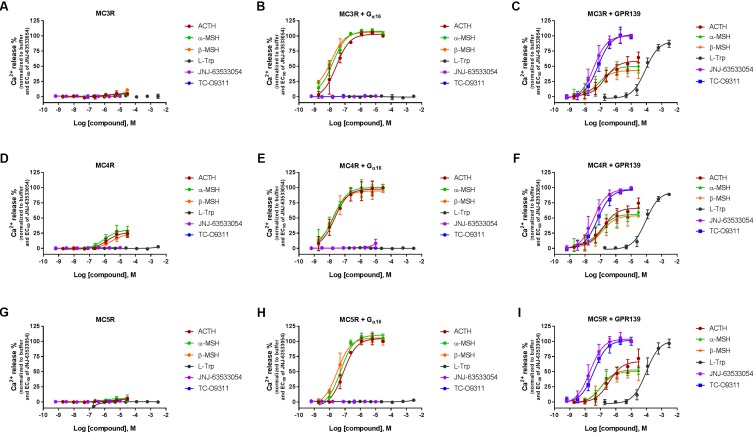
Concentration response of the MC agonists ACTH, α-MSH, β-MSH, and GPR139 agonists (L-Trp, JNJ-63533054, and TC-O9311) on calcium mobilization in HEK-293 cells transiently expressing MC3R (A), MC3R and Gα16
(B), MC3R and GPR139 (C) MC4R (D), MC4R and Gα16
(E) MC4R and GPR139 (F) and MC5R (G), MC5R and Gα16
(H) MC5R and GPR139 (I). Data are the mean ± SEM of at least three separate experiments performed in duplicates.